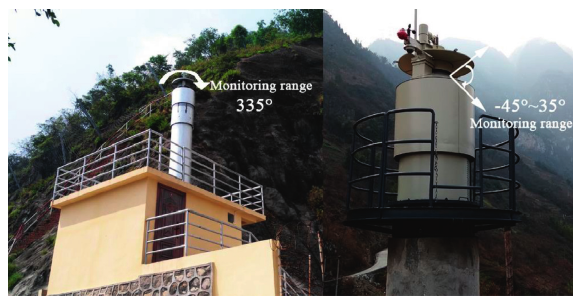
Figure 3: Drawing of the large field angle in the smart